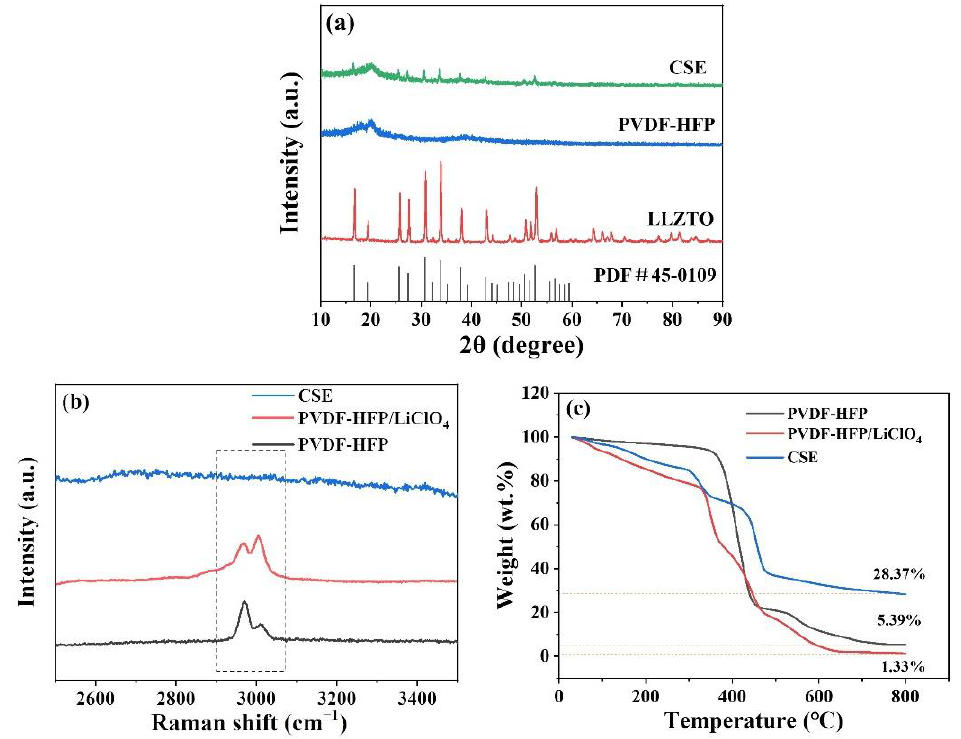
Figure 3. ( a ) XRD, ( b ) Raman, and ( c ) TG of PVDF-HFP, PVDF-HFP-LiClO 4 and CSE.